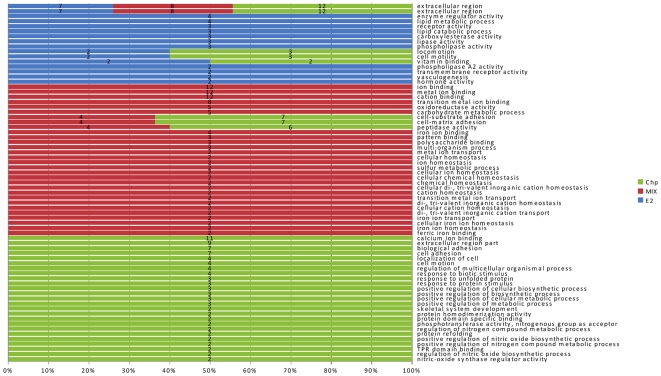
Functional genomics analysis: GO bar chart.GO terms (biological processes, molecular functions and cellular
components) were obtained from a hypergeometric statistics (P<0.05)
comparing the distribution of GO terms from each gene list with that
obtained from the whole microarray catalogue. Bar length represents the
relative frequency (%) of a GO term in each analyzed condition.
Absolute frequencies of GO terms are also reported. Only GO terms with
at least two associated genes were considered.